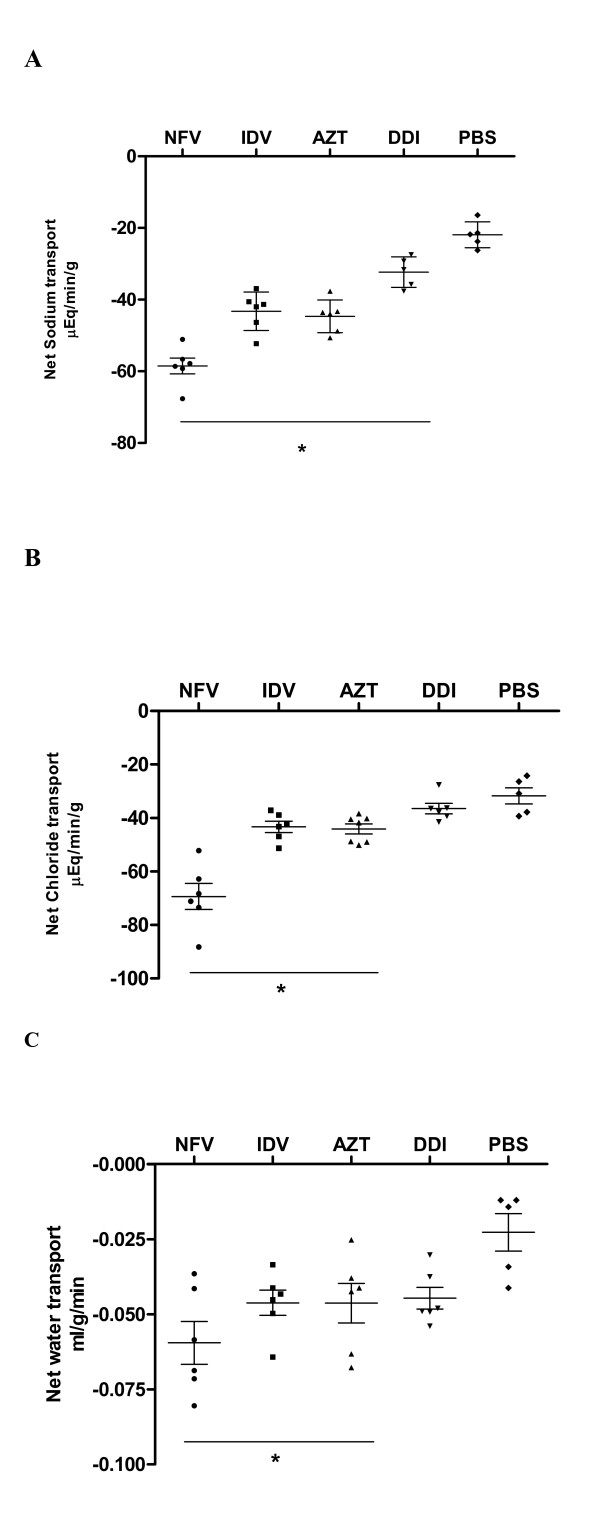
Intestinal transport of fluid and electrolytes (mEq/min/g) in experimental mice (n = at least 5 per group) after 7 days of treatment with either nelfinavir (NFV, 100 mg/kg), indinavir (IDV, 100 mg/kg), zidovudine (AZT, 50 mg/kg) and didanosine (DDI, 100 mg/kg) or PBS. Mice undergoing protease and reverse transcriptase inhibitors were submitted to intestinal perfusion (60 min) with ringer lactate. The results are expressed as mean ± SEM of at least 5 mice per group. *statistical significance (P < 0.05) compared to the PBS control group by ANOVA, Bonferroni's multiple test. A: sodium; B: chloride and C: fluid transport.